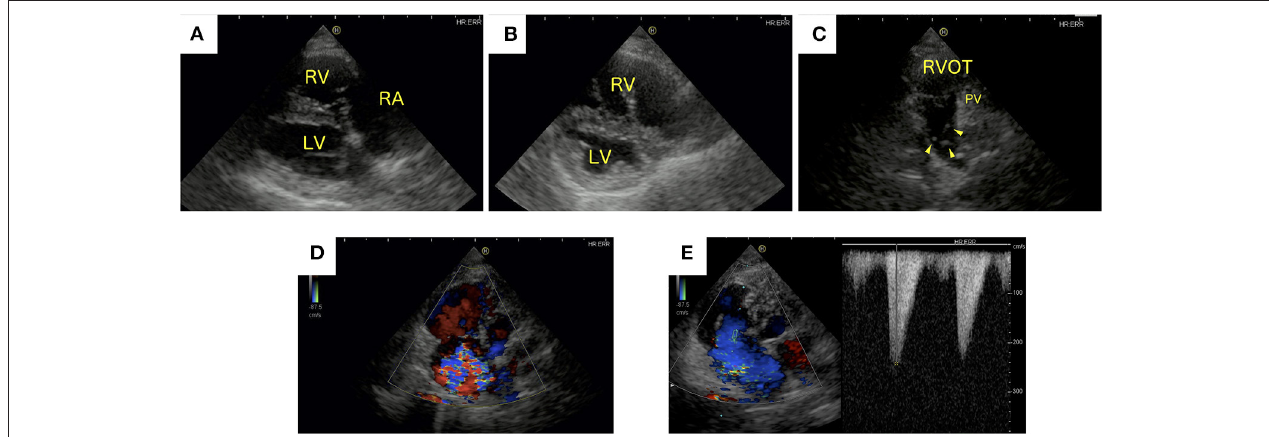
FIGURE 1 | Echocardiographic images generated at initial presentation. (A) Right parasternal long-axis and (B) short-axis papillary muscle levels of the heart. (C) Left parasternal short-axis view of the heart. (D) Color Doppler image showing tricuspid regurgitation (TR) from a left apical, four-chamber view of the heart. (E) Continuous wave Doppler signal of the TR. (A,B) Right atrial and right ventricular dilatation and flattening of the interventricular septum was observed. (C) Heartworms were identified in the main pulmonary artery (arrowhead). (D) Severe TR was present. (E) Continuous wave Doppler examination of the tricuspid valve showing the characteristic dagger-shaped regurgitant signal. LV, left ventricle; PV, pulmonic valve; RA, right atrium; RV, right ventricle; RVOT, right ventricular outflow tract.